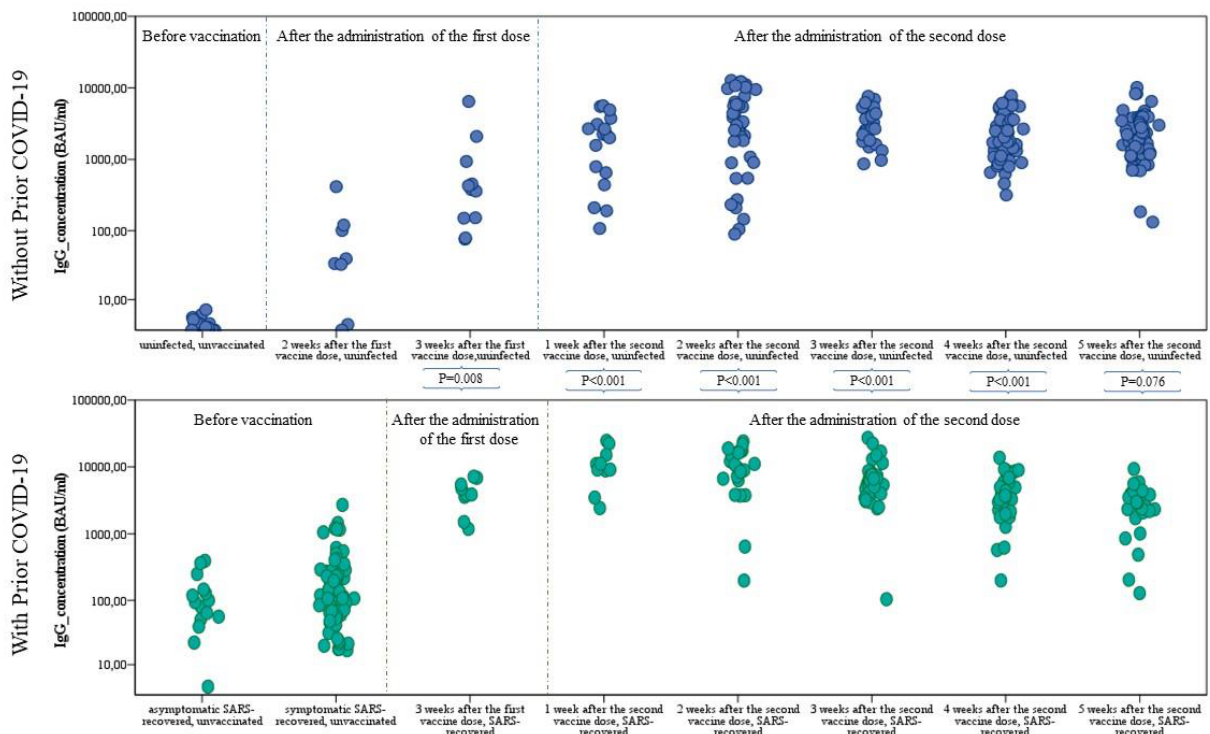
Figure 1. Comparisons of antibody levels between the analyzed patients’ subgroups. Blue indicates the concentration of anti-SARS-CoV-2 IgG antibodies in seronegative individuals before vaccination. Individuals with confirmed SARS-CoV-2 infection prior to receiving the mRNA vaccine dose, as well as for seropositive unvaccinated individuals, are marked in